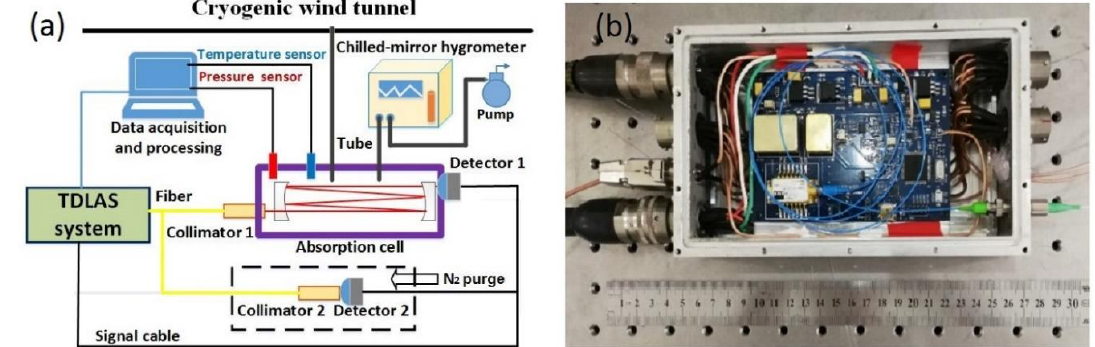
Figure 2. A TDLAS-based sensor for real-time online measurements of dew/frost point temperature in a cryogenic wind tunnel. A chilled-mirror hygrometer was used temporally for comparison measurements. ( a ) The schematic diagram of the experimental setup; ( b ) Photo of the compact TDLAS sub system.